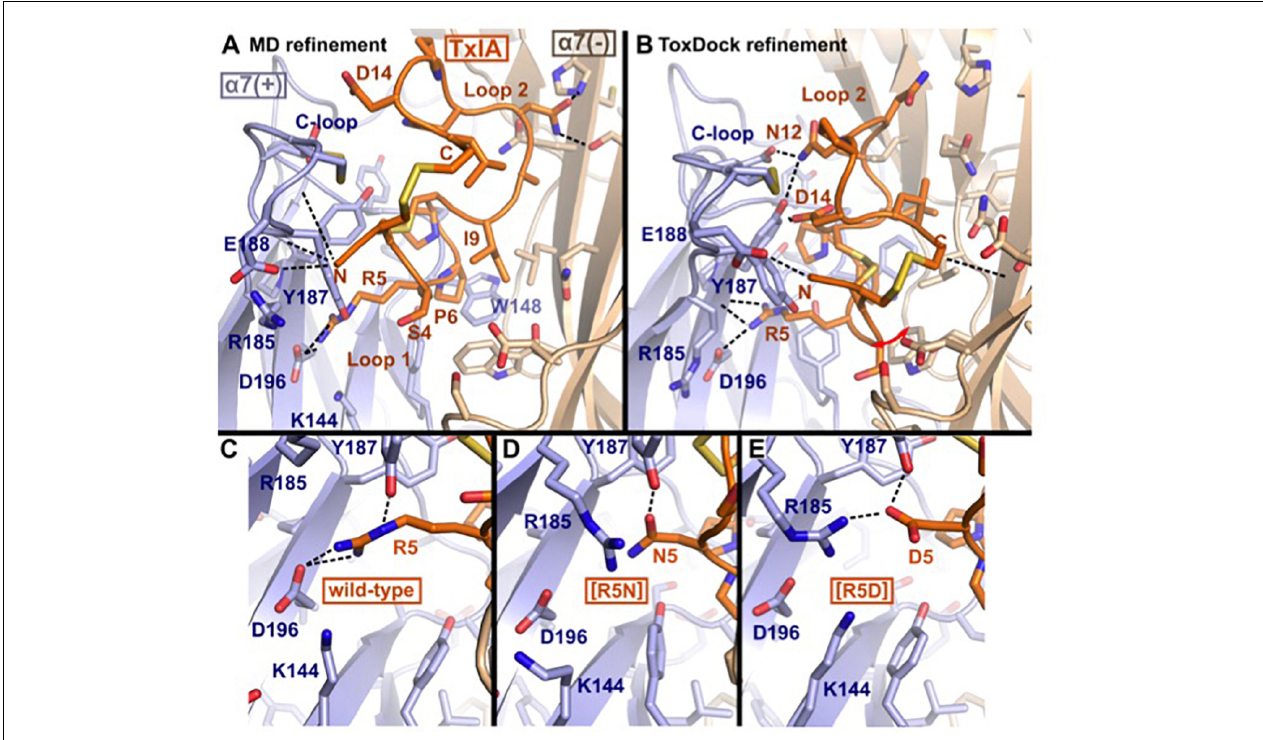
FIGURE 5 | Molecular models of the binding modes of ribbon TxIA at the α 7 nAChR: (A) MD-refined molecular model, (B) ToxDock refined molecular model, and interaction of position 5 in the MD-refined model of (C) ribbon TxIA, (D) ribbon [R5N]TxIA, or (E) ribbon [R5D]TxIA. The last frame of the 50 ns MD simulation is shown in (A) . The model with the lowest re-weighted Rosetta score is shown in (B) . The backbone of the receptor and peptides are shown using cartoon representation [blue and wheat color for the principal (+) and complementary (–) subunits, respectively], the side chains of the toxins are shown as sticks (orange) and the side chain of receptor residues located at less than 5 Å from the toxin are shown in stick representation. Hydrogen bonds are indicated by dashed black